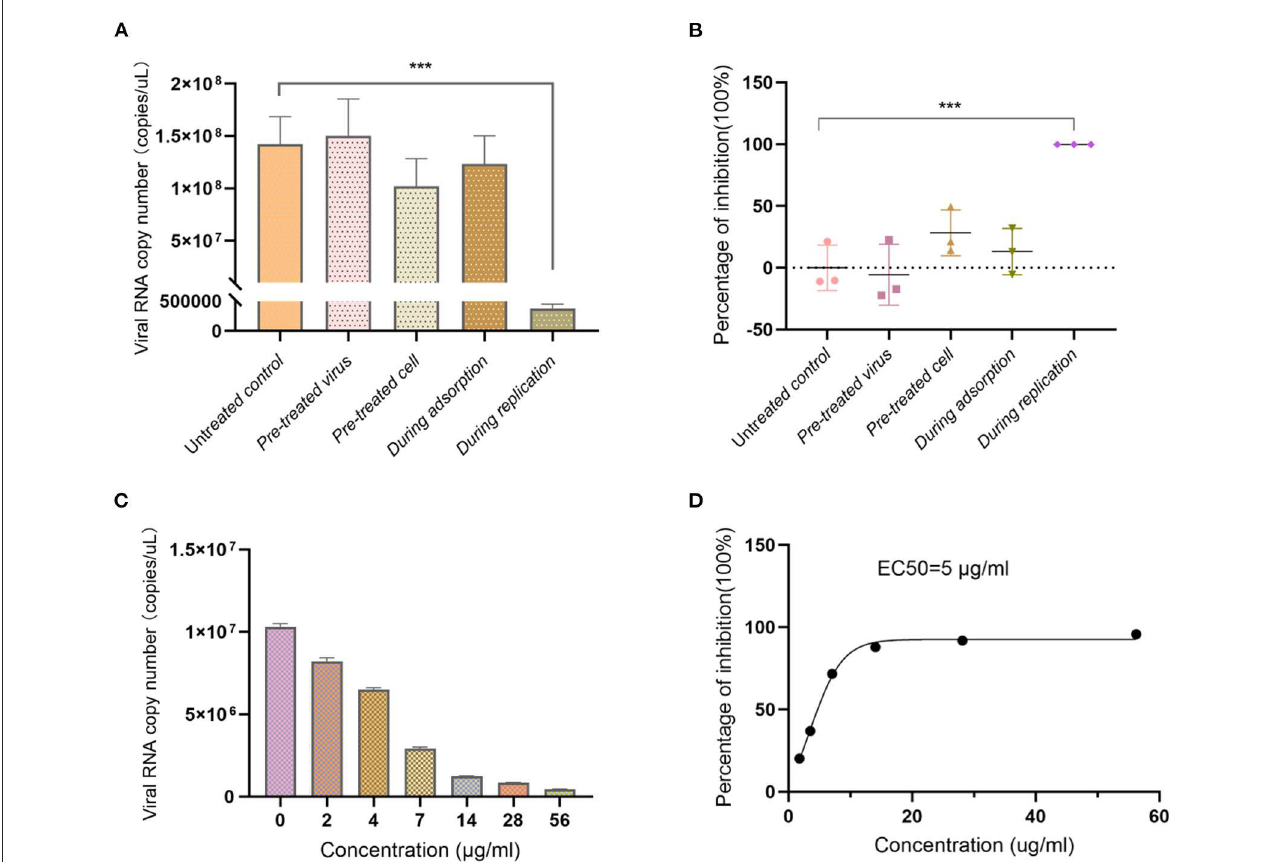
FIGURE2 Anti-influenza virus effect of Ren’s oligopeptide. (A) Virus copy number of H1N1 after addition of Ren’s oligopeptides to the MDCK cells at different viral infection stages. (B) Virus inhibition rate after addition of Ren’s oligopeptide to cells at different viral infection stages. (C) Inhibition rate at different concentrations of Ren’s oligopeptides on H1N1 virus. (D) Ren’s oligopeptide anti-H1N1 dose-dependent curve. ns, not significant ( p > 0.05); *** p < 0.001 from the Student’s t -test. Error bars represent SD from three independent